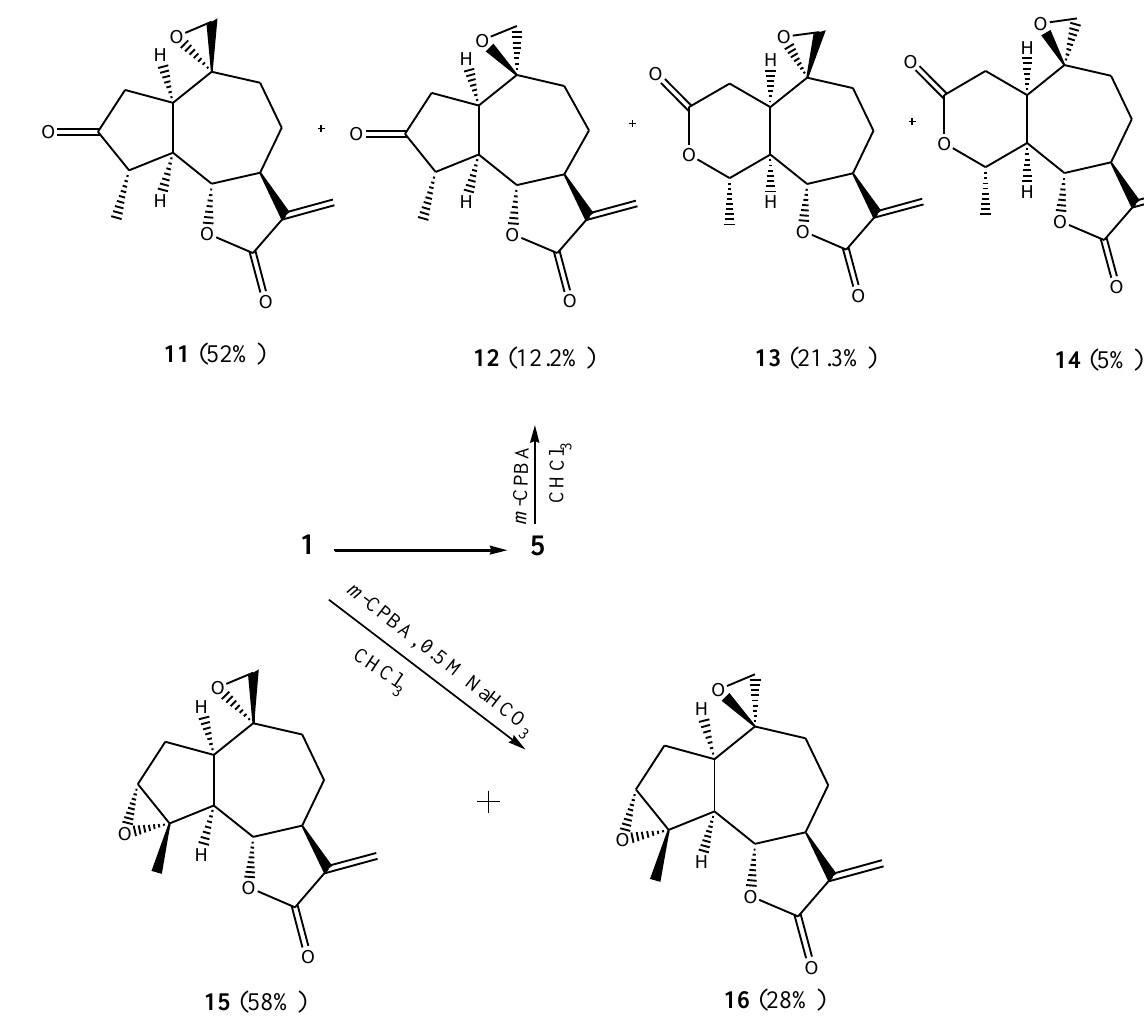
Table 2. Chemical shifts (in ppm) and spin – spin coupling constants ( 1 H NMR, 500.16 MHz, CDCl 3 , δ , ppm, in brackets, in Hz) for estafiatin derivatives 11 –